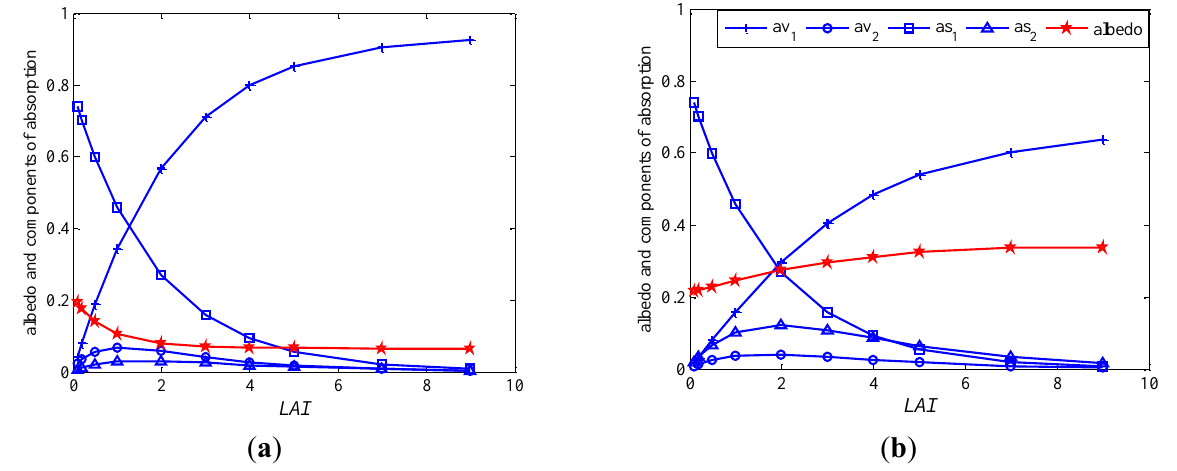
 = 0.23 (green l    r  20 s g